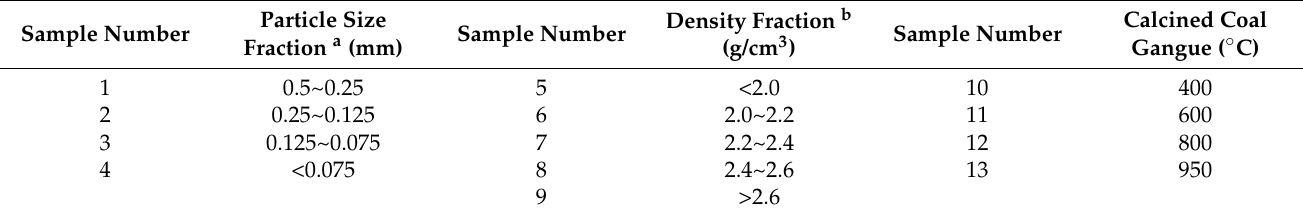
Table 2. Sample information of physical separation and